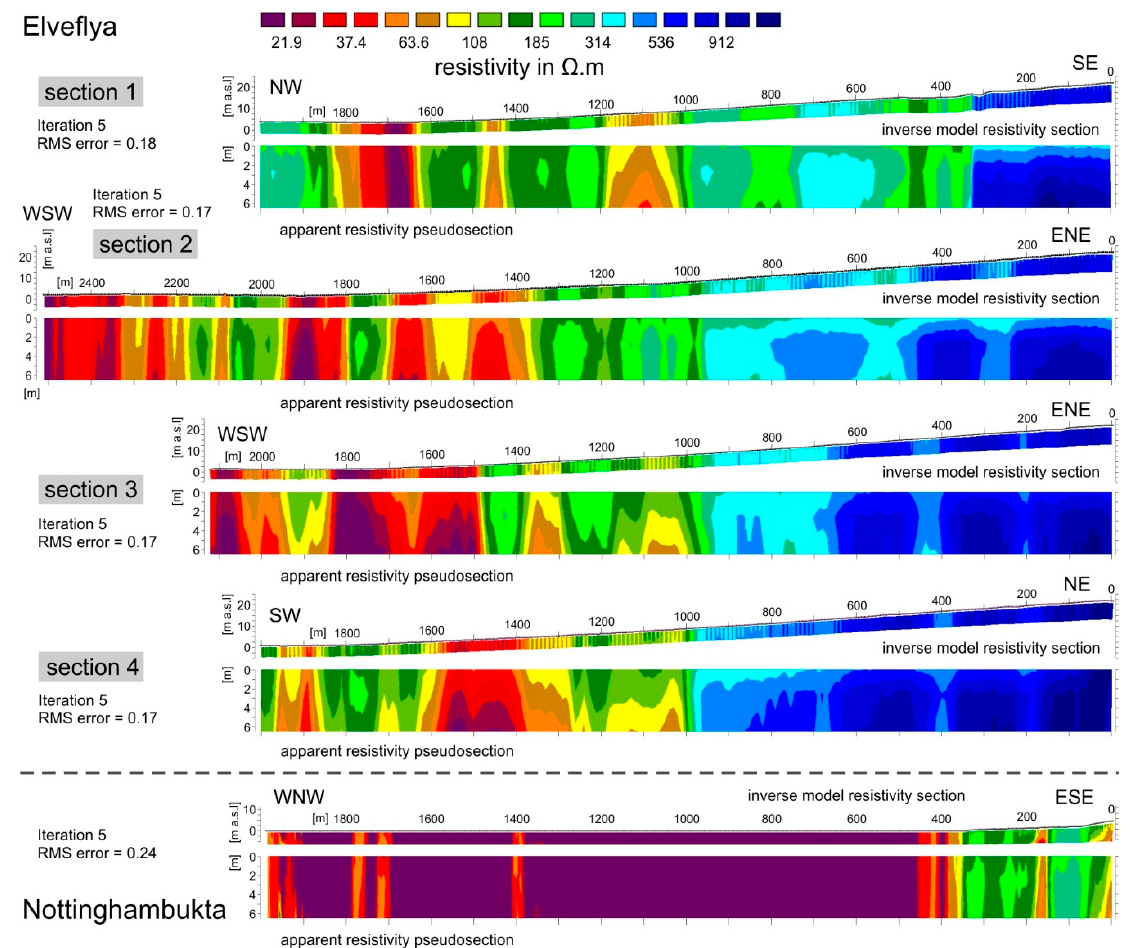
Figure 9. Electrical resistivity of the ground in sections 1–5 (see Figure 2), the vertical exaggeration in the inverse models is 5.